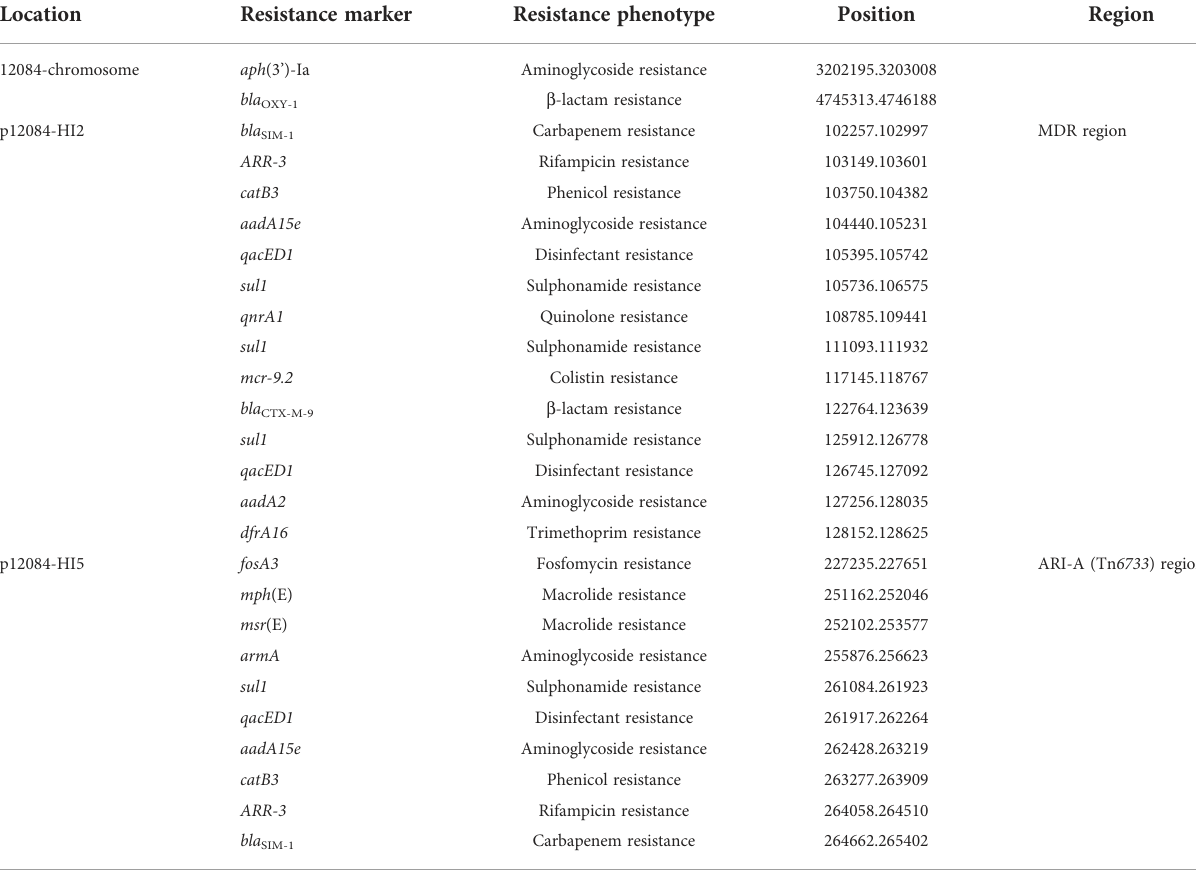
TABLE 3 Resistance genes in strain